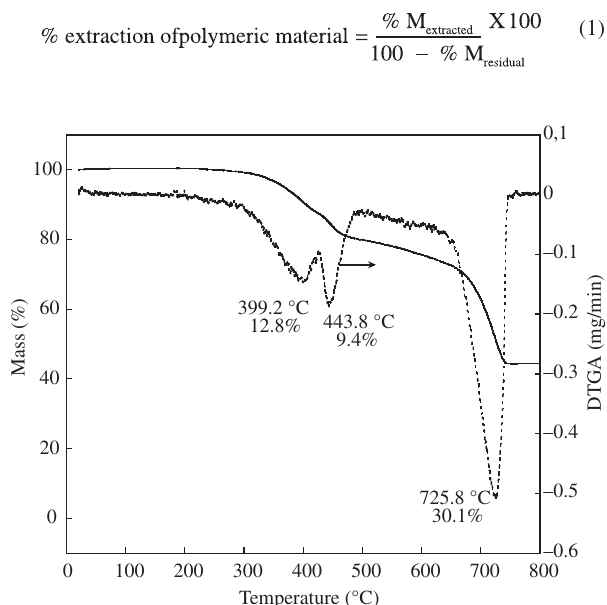
flow of 50 mL/min with a heating 2